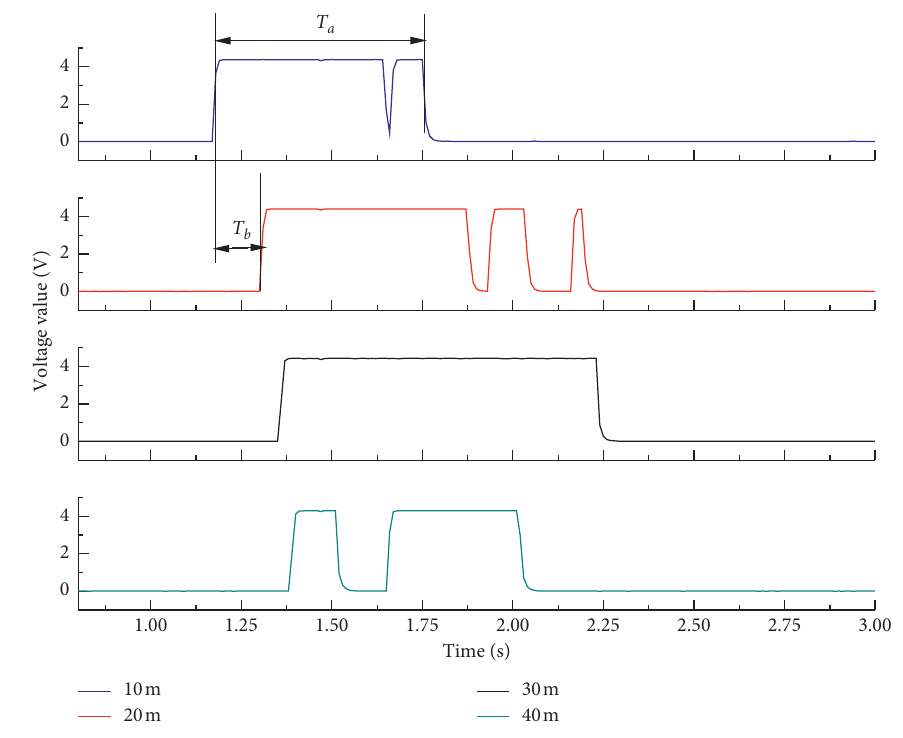
Figure 4: Flame signals at various measurement points.